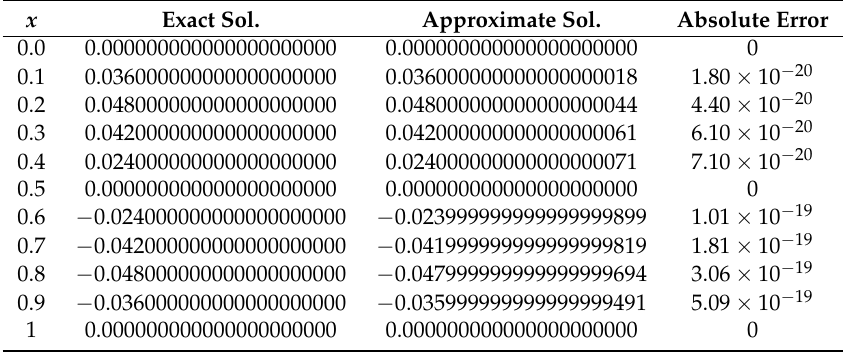
Table 3. Numerical results of Example 1 for m = 5, n = 9 values ( α = 1.75, β =